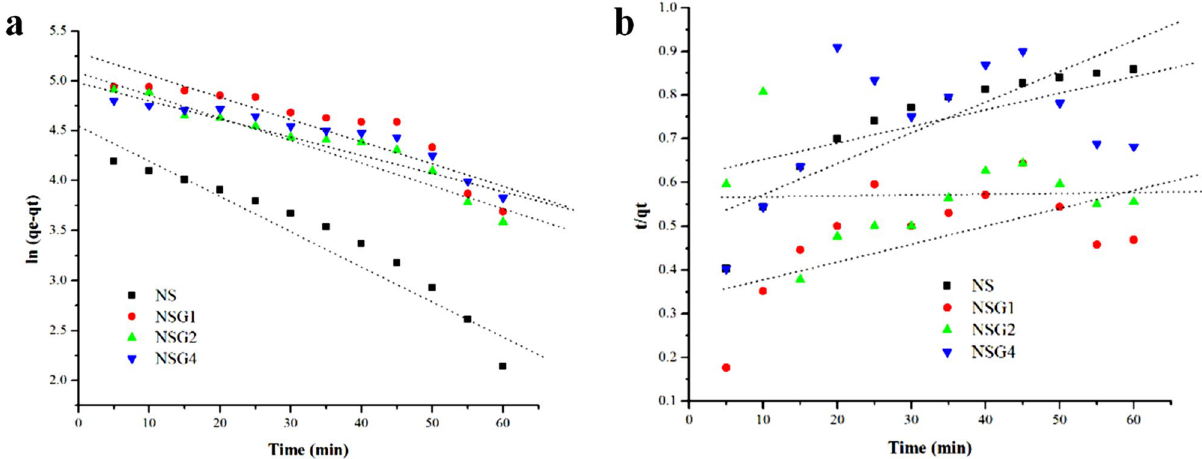
Figure 9. Pseudo-first ( a ) and pseudo-second-order ( b ) linear plots for the removal of MB by samples.